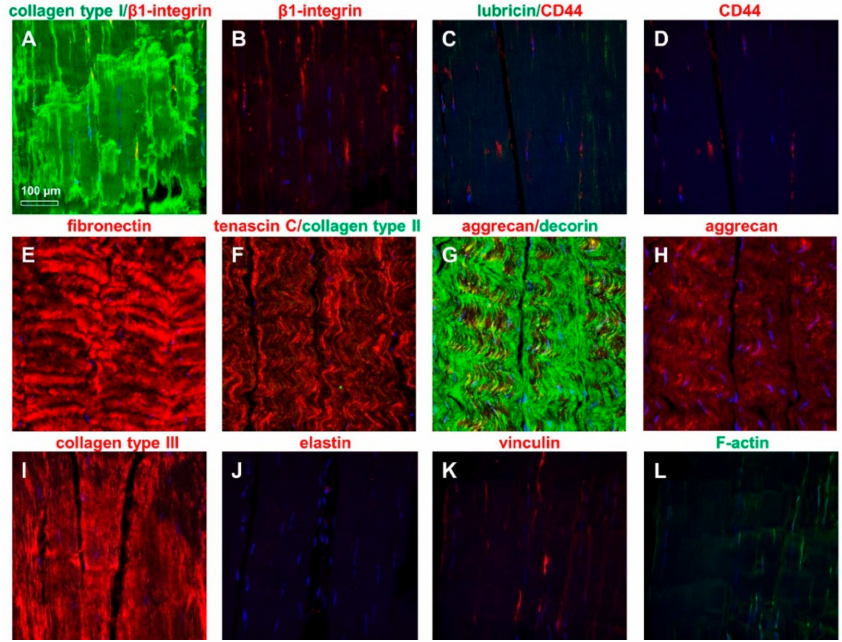
Figure 4. The immunolabeling of the extracellular matrix (ECM) and cytoplasmatic markers in ITB tissue: Collagen type I (green) and β 1-integrin [( A ) merged, ( B ) β 1-integrin (red)], lubricin (green) / CD44 (red) [( C ) merged, ( D ) CD44], fibronectin [( E ) red], tenascin C (red) / collagen type II (green) ( F ), aggrecan / decorin [( G ) merged, ( H ) aggrecan], collagen type III [( I ) red], elastin [( J ) red], vinculin [( K ) red], and F-actin [( L ) green]. The cell nuclei were counterstained using 4’,6-diamidino-2-phenylindole (DAPI). Scale bar: 100 µ